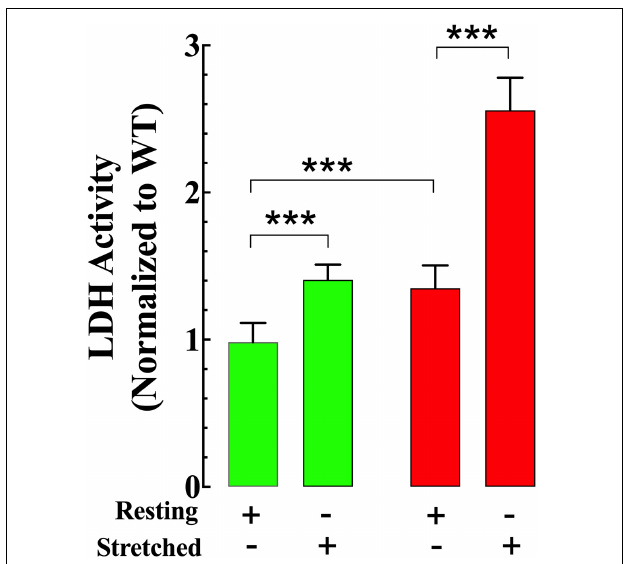
FIGURE 9 | Stretch induces greater cell damage in mdx VSMCs. LDH activity in the supernatant from non-stretch VSMCs was higher in mdx than Wt. Muscle elongation increases LDH activity in both genotypes; however, it was much greater in mdx than Wt. For LDL: n mice = 3/experimental condition, n cell = 17–20/genotype. Values are expressed as means ± S.D. for each condition. Student’s t -test, *** p ≤ 0.001.